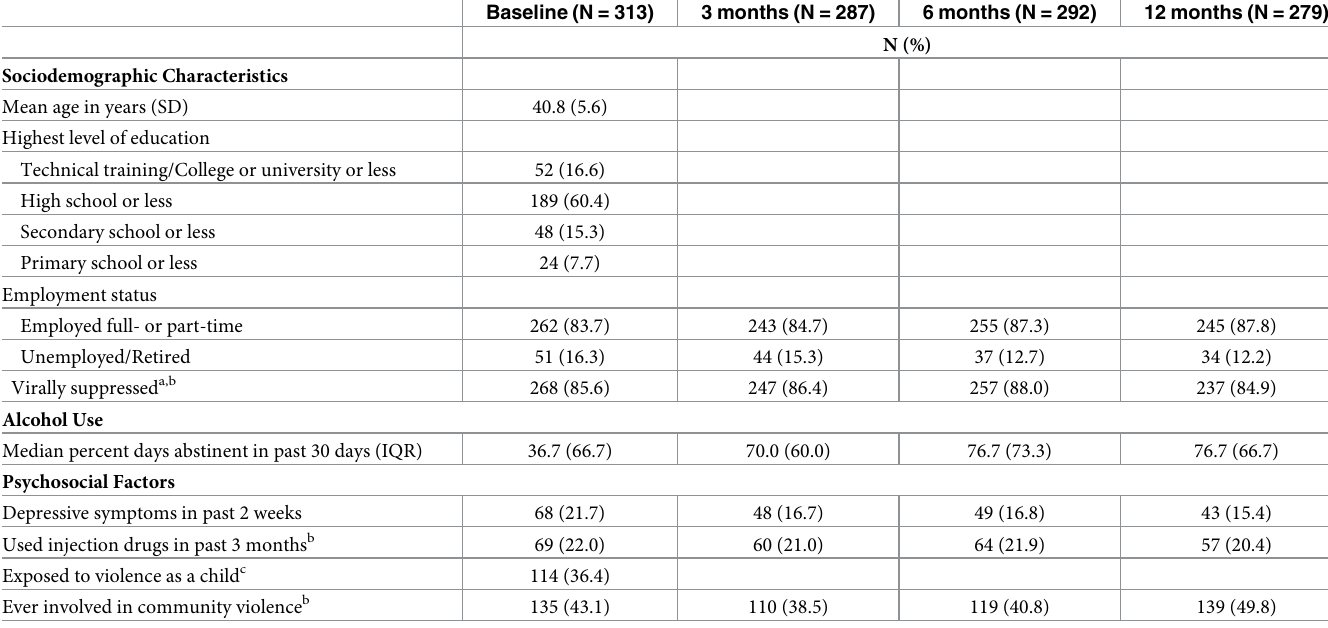
Table 1. Characteristics of male participants who were married or cohabiting with a partner (N = 313). Baseline (N = 313) 3 months (N = 287) 6 months (N = 292) 12 months (N =